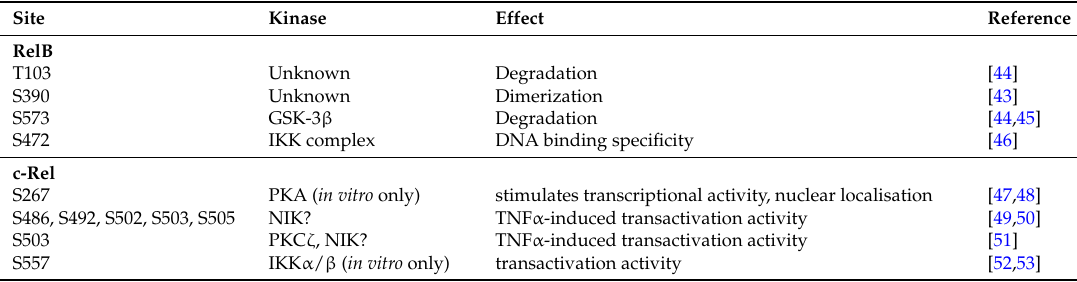
Table 2. Phosphorylations of the RelB and c-Rel NF- κ B